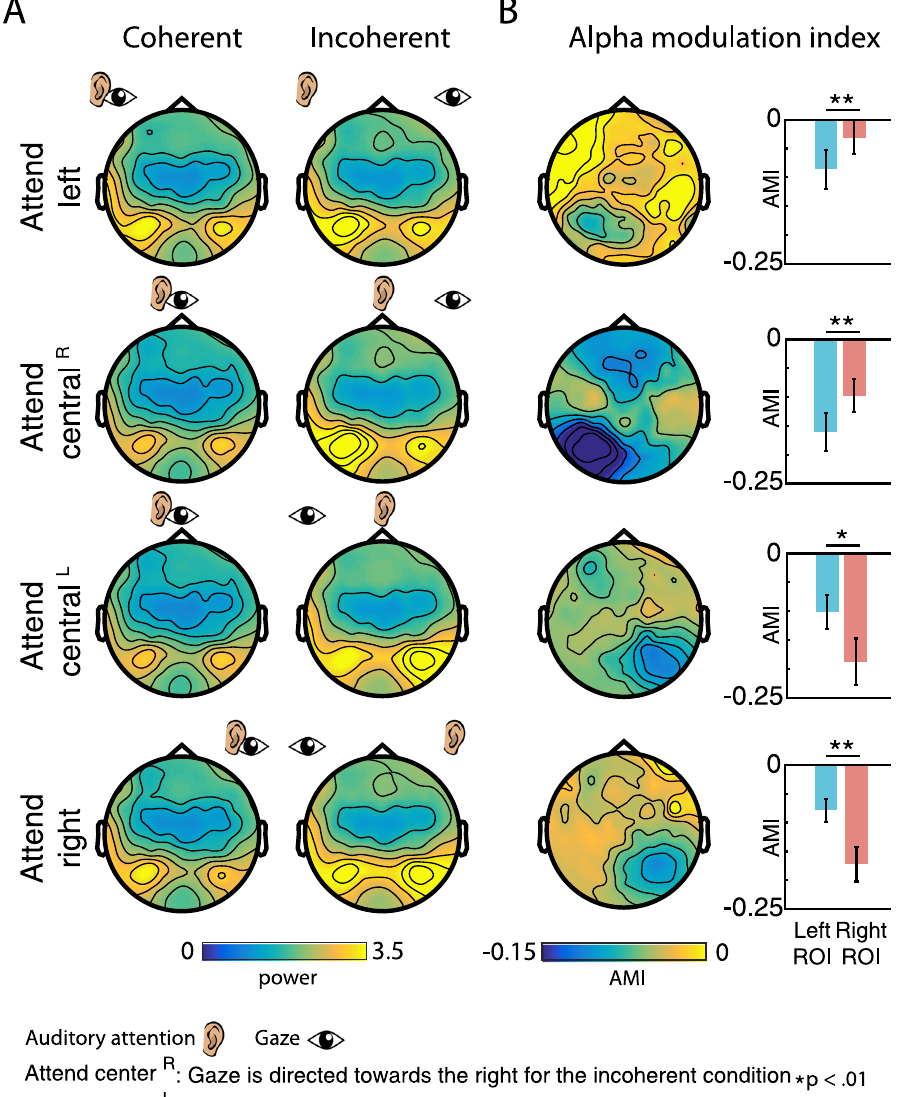
Figure 7. Topographies and statistical results for alpha-band power. ( A ) Topographies of alpha-band (8–14 Hz) power for the coherent (left column) and incoherent condition (right column). Occipital alpha-power is overall increased in the incoherent condition. Data are presented separately for conditions in which participants attended towards the left (top row), towards the center (middle two rows), and towards the right (bottom row). For attend central R (upper middle row) gaze is directed towards the right in the incoherent condition. For attend central L (lower middle row) gaze is directed towards the left in the incoherent condition. For each condition, the ear icon indicates the direction of auditory attention, while the eye icon indicates the direction of gaze. ( B ) Topographies (left column) and statistical results (right column) for the alpha-modulation index (AMI, − alpha power coherent ). Data are presented separately for the attend-left, attend-central R , + ) attend-central L , and attend-right. Occipital AMI was significantly lateralized for all attention locations, due to stronger alpha-power contralateral to the direction of gaze in the incoherent